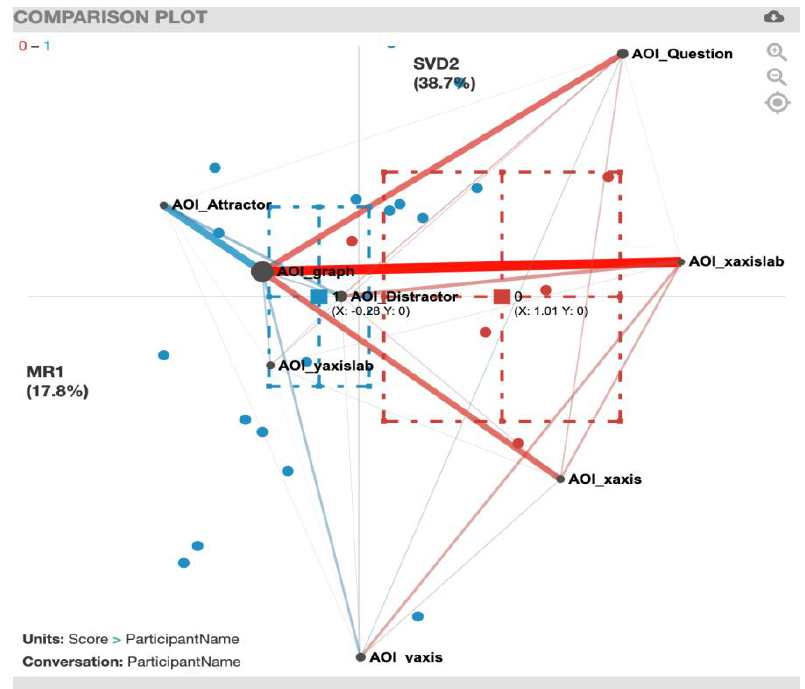
Figure 9 . EcSlopeQual transitions with incorrect solvers (red) and correct solvers (blue). Sensors 2020 , 20 , x For the ENA plot of the PhySlopeQual task (Figure 10), along the x -axis, a two-sample t -test assuming unequal variance (mean = −1.30, SD = 0.49, N = 4) indicated statistically significant differences at the alpha level = 0.05 (mean = 0.27, SD = 1.06, N = 19; t(10.10) = −4.56, p = 0.00, Cohen’s d = 1.58). In this plot, the strong gaze transition correlation between AOI_Attractor and AOI_Distractor among the correct solvers (blue) is notable. For a summary of the strong gaze transition correlations, see Table 6.